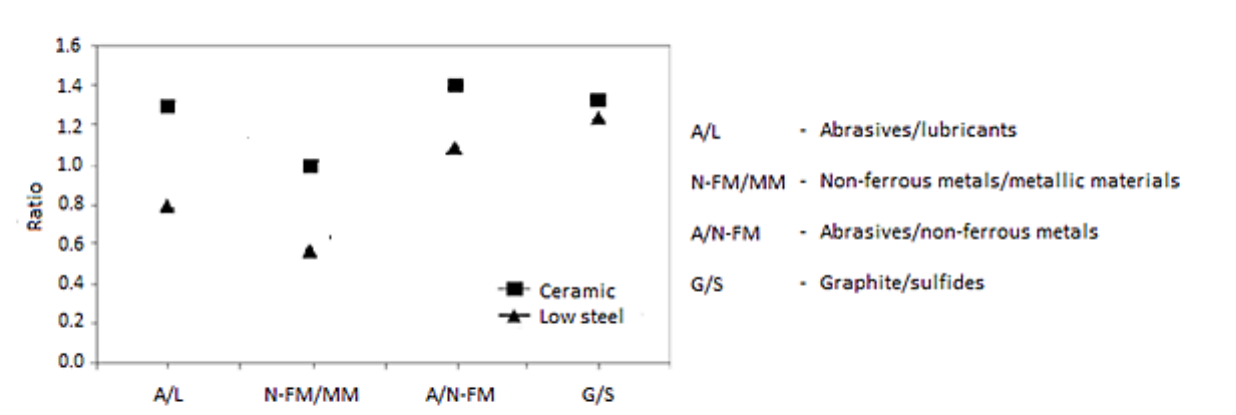
Figure 3. The classical ratio between the main friction materials categories.